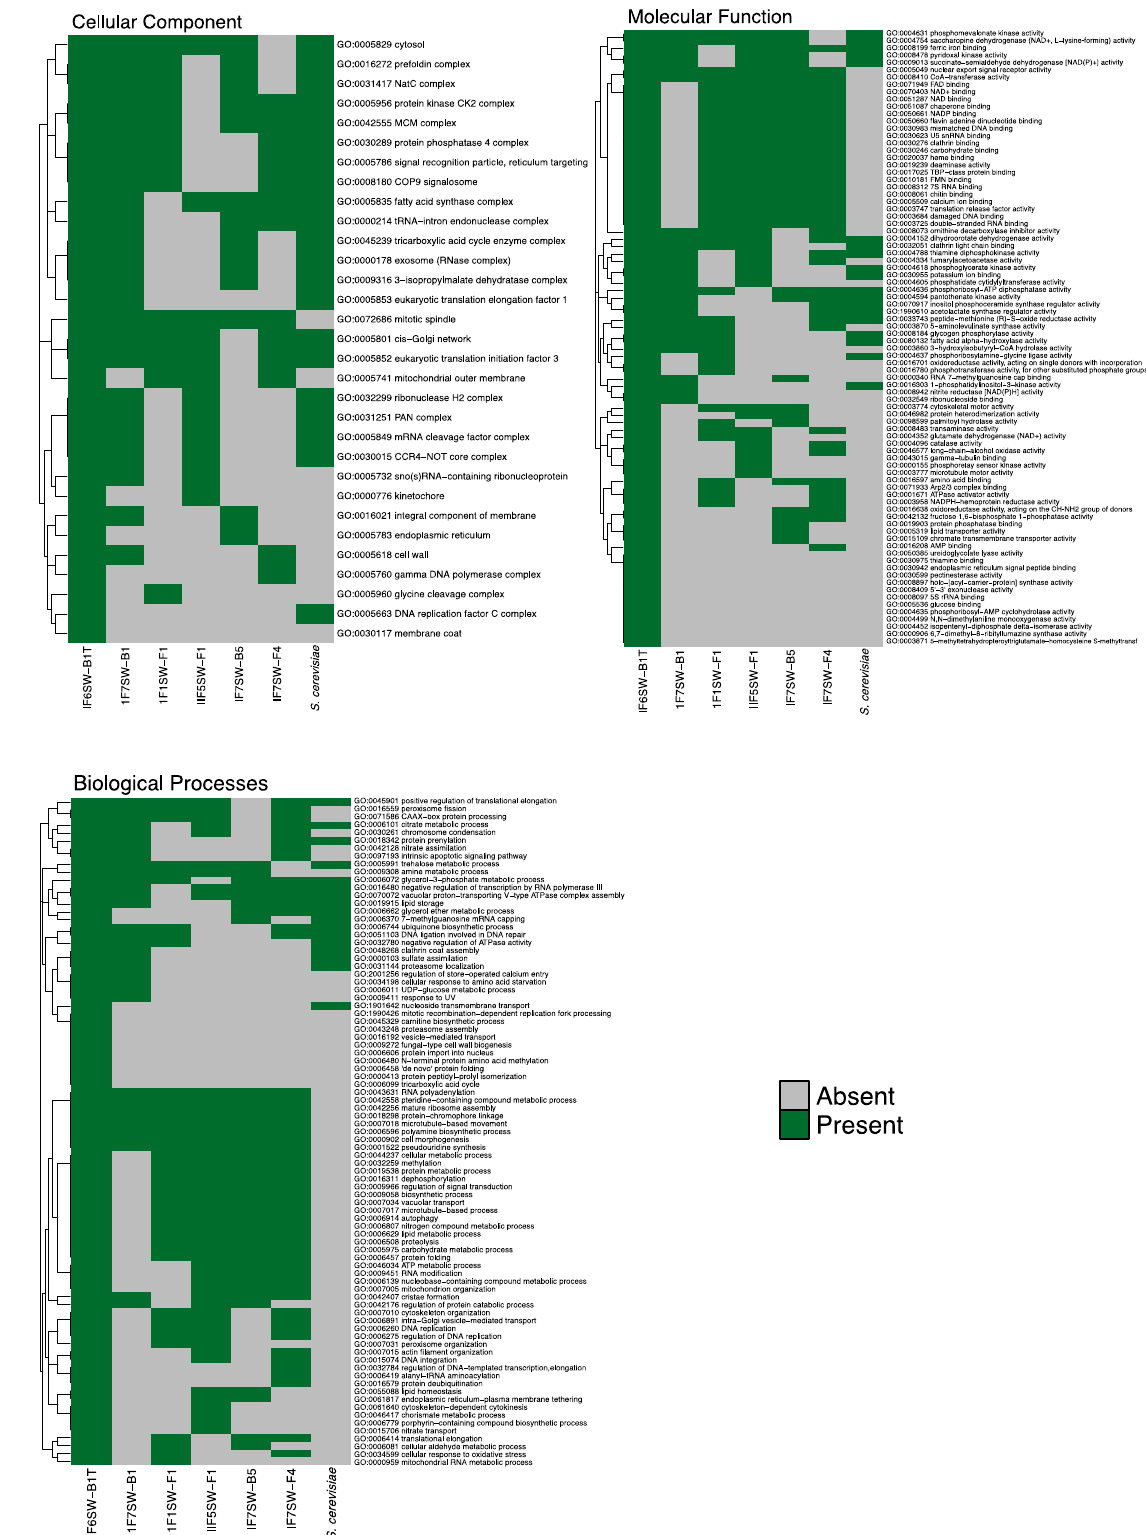
Figure 5. Enriched GOSlim terms for biological process, cellular components, and molecular function in N. tulchinskyi genome. The Gene Ontology terms were summarized by purging redundant GO terms that were deduced by orthologous searches coupled with semantic similarity-based scatterplots using the REVIGO platform [58].